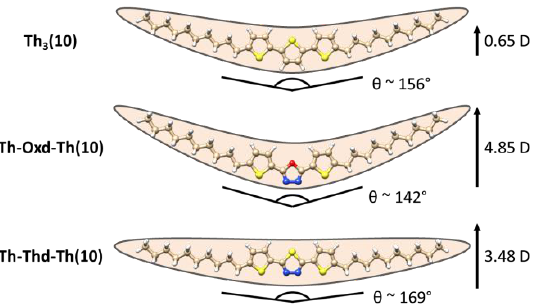
Figure 6. The optimized structures of the compounds studied, showing differences in bend angle, θ, and transverse dipole moment. See Supplementary Materials for calculation details.